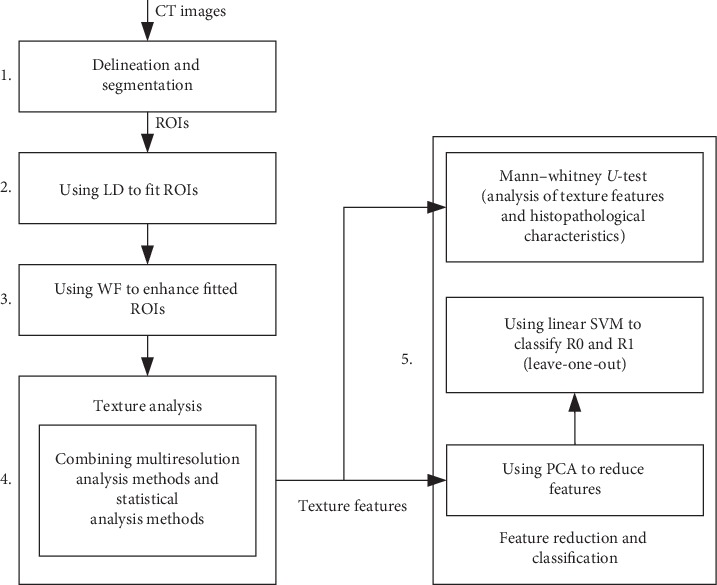
Radiomics framework.